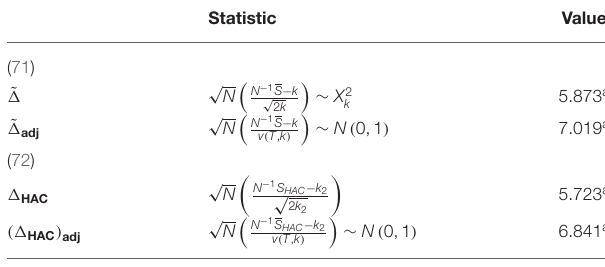
TABLE 6 | Slope homogeneity tests.